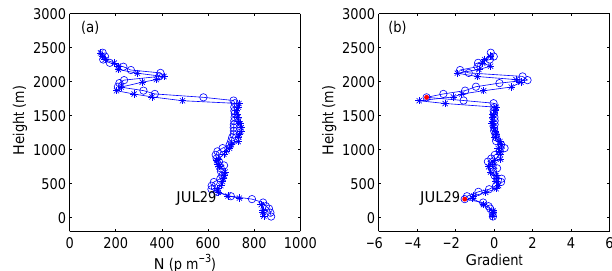
Figure 4. The vertical profile of particle extinction observed during the flight in the late morning of 29 June (a) and its gradient (b) and the vertical profiles of particle extinction before (blue) and after (red) the flight. The dashed lines indicate the lower limit of lidar.